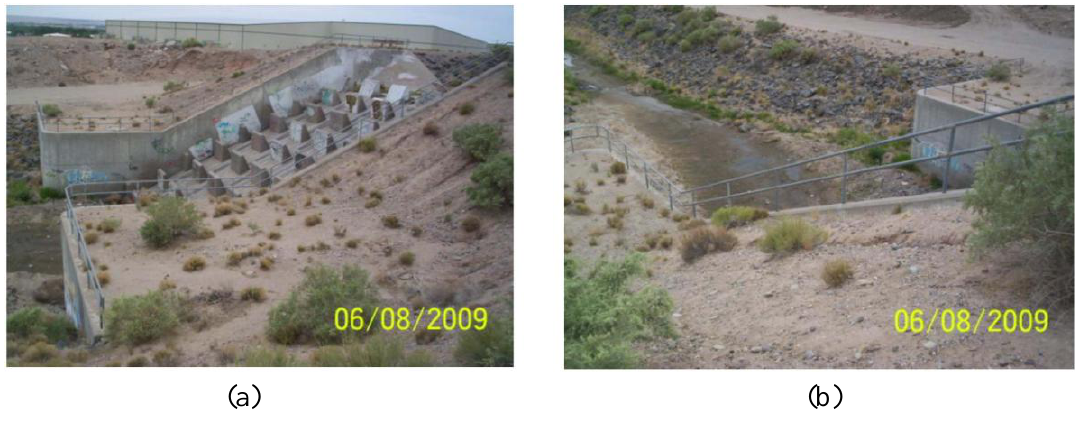
Figure 4. Photos depicting the existing condition of the SDC and baffle chute, (a)-general view and (b)-downstream